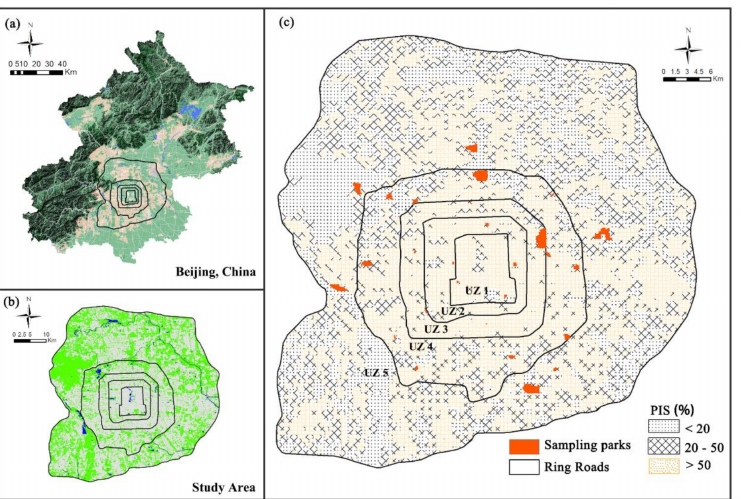
Figure 1. ( a ) Map of Beijing with the study area location within the 6th ring road; ( b ) Land cover of study area was classified into three groups: Green (green space), Grey (impervious surface) and Blue (water); ( c ) 28 sampled parks located within the 6th ring road of Beijing. We overlaid an image of Beijing within the 6th ring road with grids (each grid cell 1 × 1 km). The proportion of impervious surfaces (PIS) is the proportion of impervious surface areas within each grid